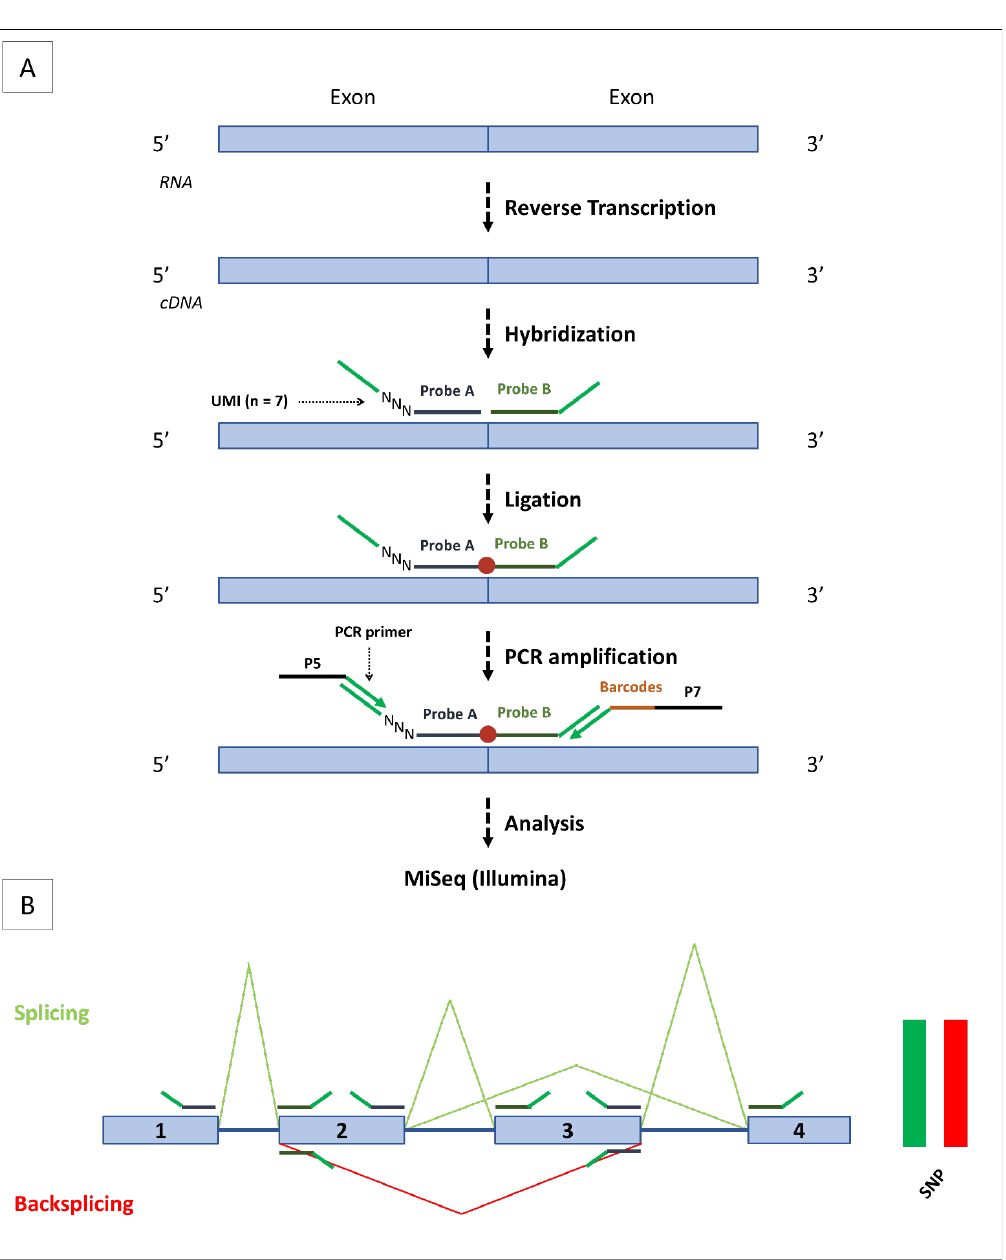
Figure 2. SEALigHTS assay. ( A ) Following cDNA synthesis, the probes are hybridized at exon extremities. Left probes include UMI consisting of a stretch of 7 random bases, depicted here as NNN. If hybridization takes place, probe ligation (depicted as a red dot) will occur. Then, PCR amplification will be performed using 2 universal complementary primers on the ends of each probe. Primers contain P5 or P7 adapters, which hybridize to the flow cell. Sample identification barcodes are included in the right primer. ( B ) Schematic representation of splicing and backsplicing results. Exons are represented as boxes and are numbered, with introns represented as lines. The probes are placed at exon extremities. Splicing junctions are represented in green, with backsplicing junctions in red. Peak heights depend on the number of UMI counts. Exon 3 skipping and exon 3-exon 2 backsplicing are shown as examples. On the right side, a balanced heterozygous SNP (i.e., with the same number of UMI counts) is depicted in red and green for the 2 allelic versions.